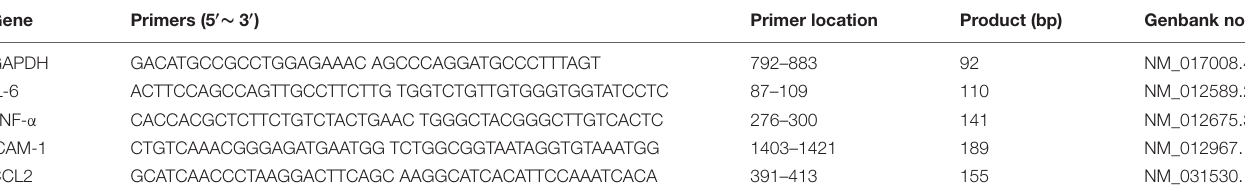
TABLE 1 | Primers used for RT-PCR. Gene Primers (5 (cid:48) ∼ 3 (cid:48) ) Primer